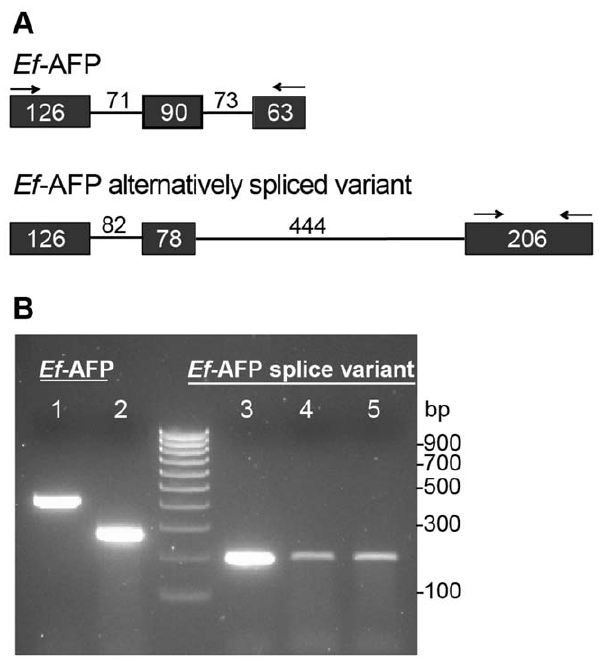
Figure 3. Detection of an alternatively spliced variant of Ef-AFP . A. Structural features of the Ef-AFP gene and the alternatively spliced variant. Exons are depicted as dark boxes, introns as lines, and sizes are given in bp. Arrows indicate positions of primers used for PCR amplification. B. PCR products of (1) Ef-AFP using E. festucae genomic DNA, and (2) E. festucae -infected plant cDNA generated from oligo(dT) as templates; (3) partial Ef- AFP alternatively spliced variant using E. festucae genomic DNA, (4) E. festucae -infected plant cDNA generated from a gene-specific primer (Alt Ef-AFP Reverse), and (5) E. festucae - infected plant cDNA generated from oligo(dT) as